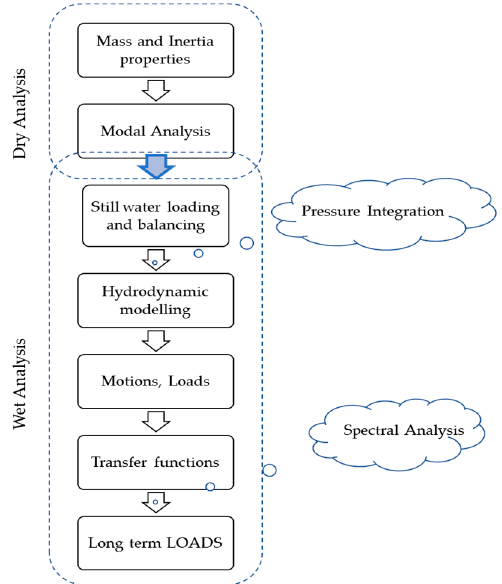
Figure 1. Hydroelastic fluid-structure interaction (FSI)-model analysis.